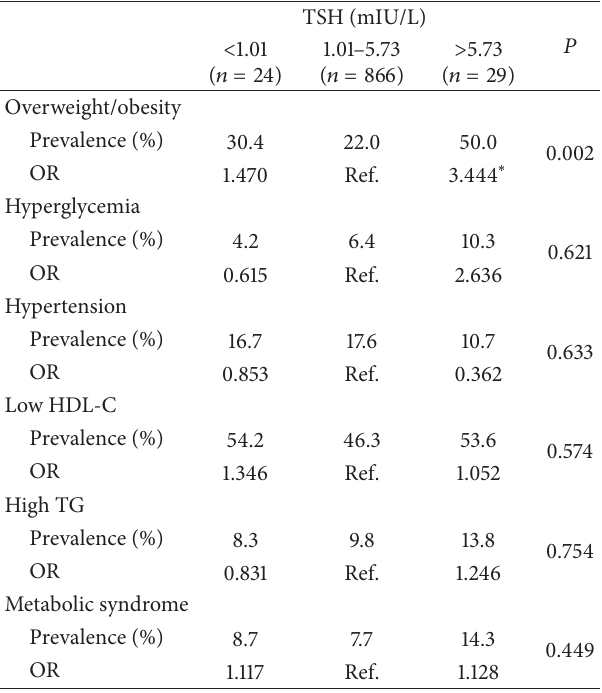
Table 2: Comparison of the prevalence of metabolic syndrome and its components in groups with different serum TSH